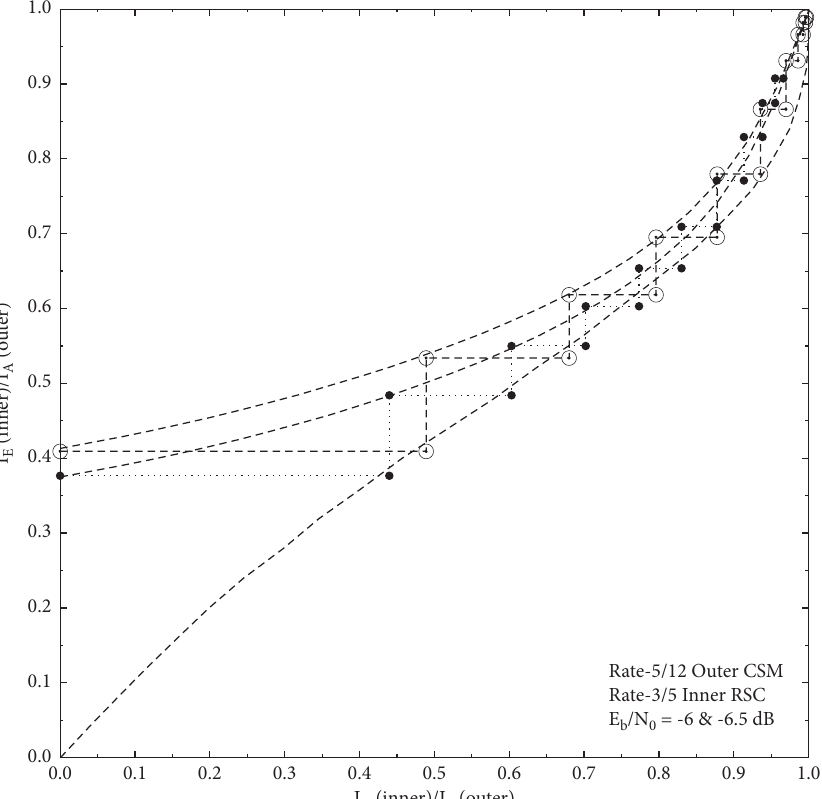
Figure 11: EXIT chart curves and decoding trajectories for Rate-5/12 CSM ( Mapping-II )